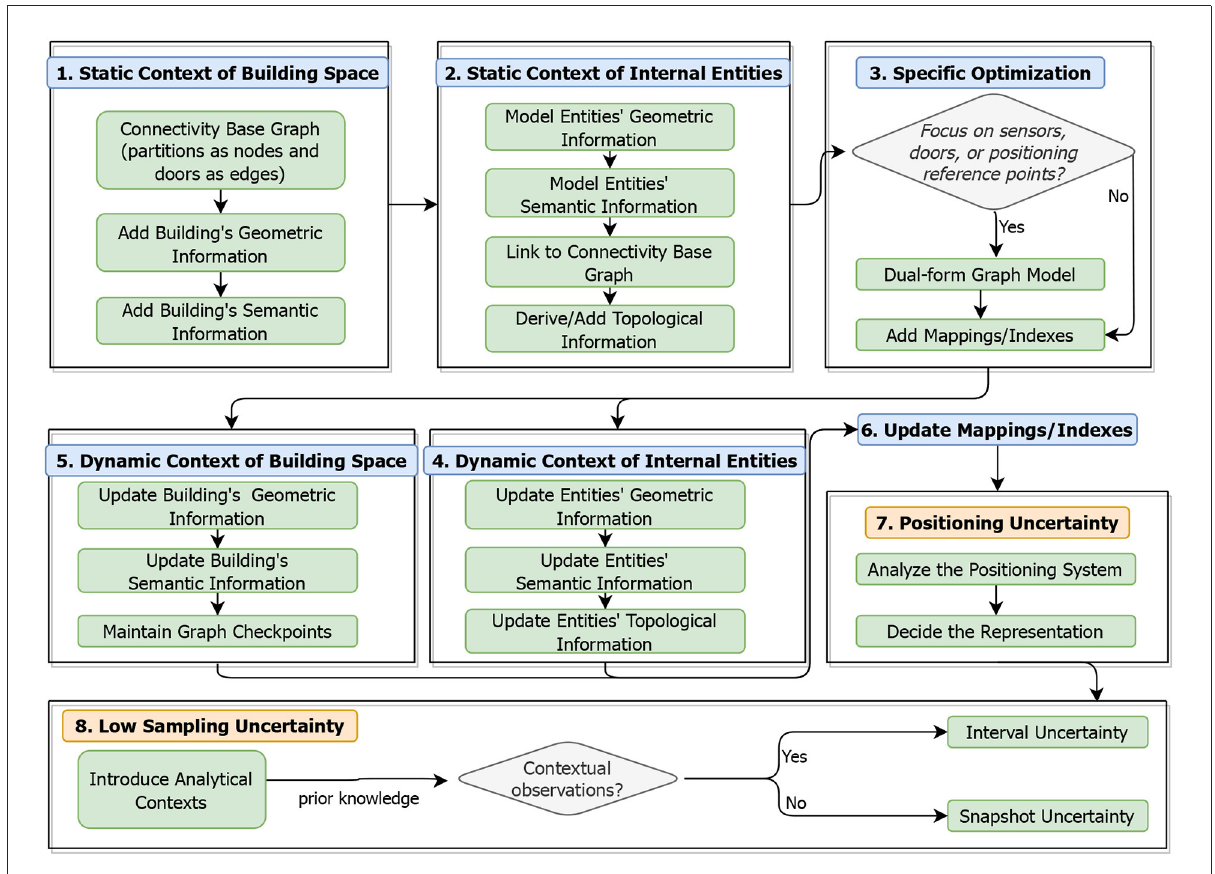
FIGURE6 A unified framework for modeling analytical contexts and spatial data